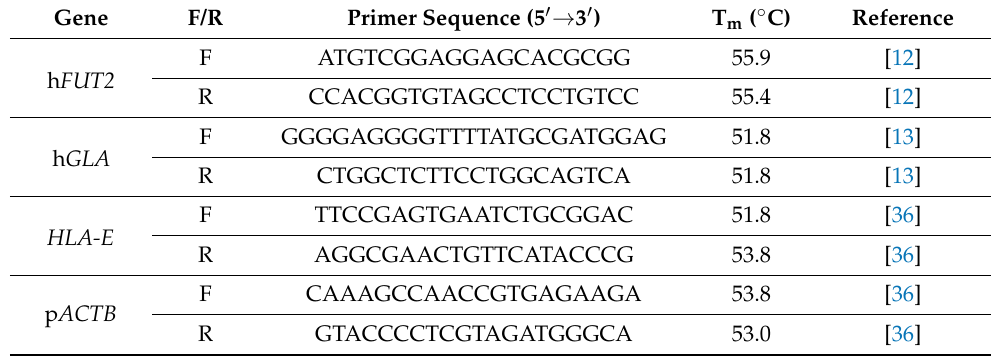
Table 1. Primers used for